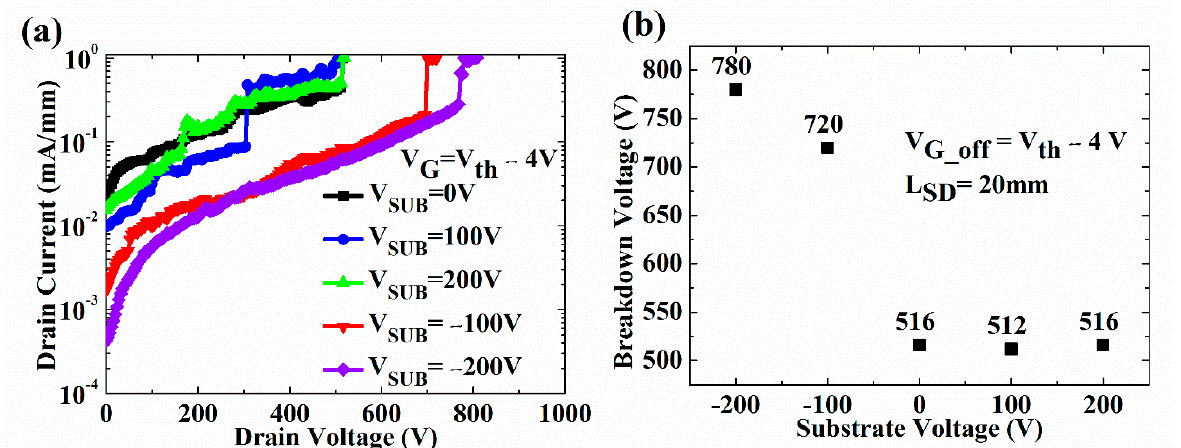
Figure 5. ( a ) Off-state drain leakage current of the GaN-on-Si HEMT as a function of substrate voltage in the log scale. ( b ) BV at different V D, off as a function of various V SUB. The dynamic R on characteristics for the HEMT devices with different V sub were also measured. After each dynamic R on measurement, the device’s initial state is fully recovered by shining microscopic light for 30 s, so that all trapped electrons were de-trapped [28]. Figure 6a shows that the device is switched to the on-state with a total switching time of 200 μ s after 10 ms of high V D stress at off-state. As shown in Figure 6b, the positive V SUB slightly reduces the dynamic R on , while the negative V SUB significantly increases the dy- namic R on . The dynamic R on ratio for applying the positive V SUB is slightly lower than with- out V SUB (the off-state V D is from 100 to 300 V). As shown in Figure 3b, the positive V SUB